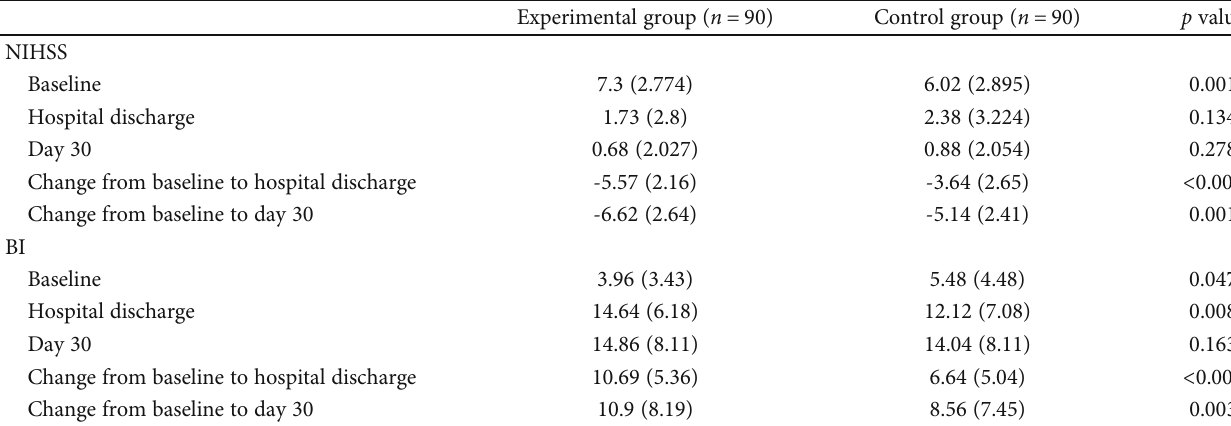
Table 3: Comparison of NIHSS and BI scores between the experimental and control groups.